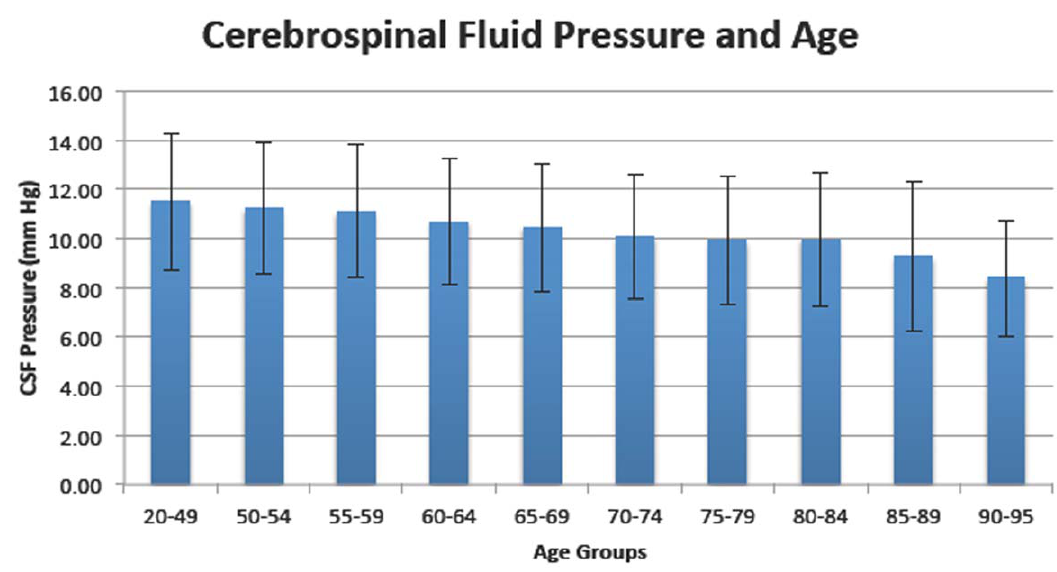
Figure 1. Mean CSFP within specific age groups. Bars represent one standard deviation.